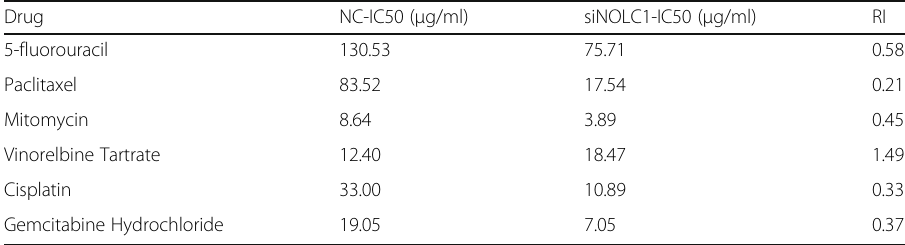
Table 2 Cytotoxicity of drugs in A549/MDR cell after siNOLC1 transfection Drug NC-IC50 ( μ g/ml) siNOLC1-IC50 ( μ g/ml) RI 5-fluorouracil 130.53 75.71 0.58 Paclitaxel 83.52 17.54 0.21 Mitomycin 8.64 3.89 0.45 Vinorelbine Tartrate 12.40 18.47 1.49 Cisplatin 33.00 0.33 Gemcitabine Hydrochloride